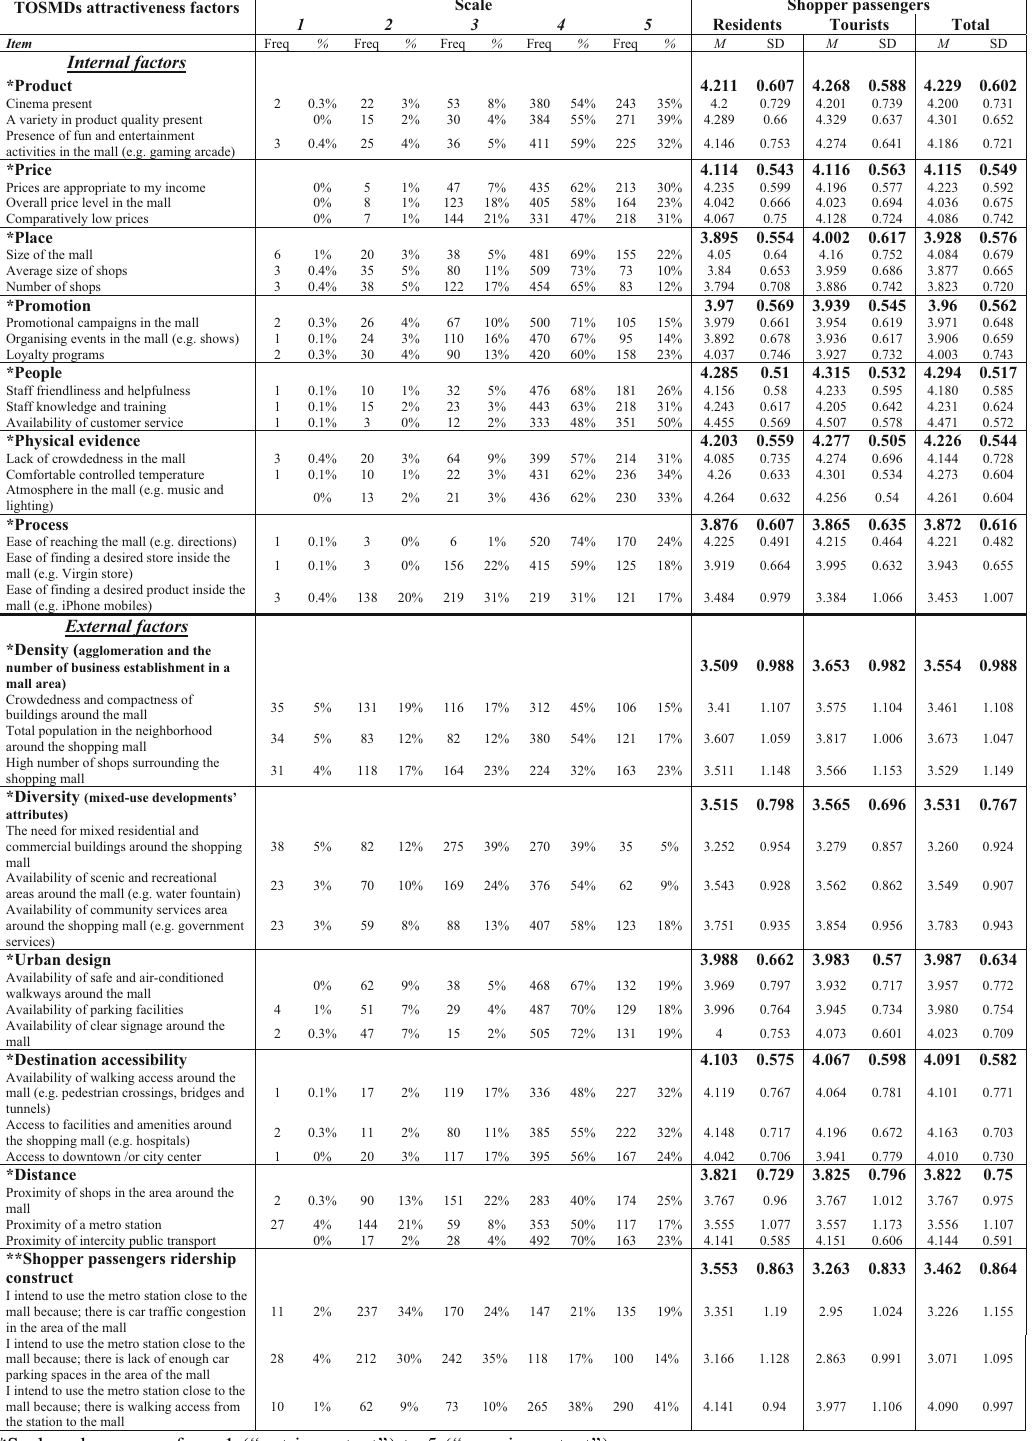
Table 1 Internal and external attractiveness factors of TOSMDs ( n =